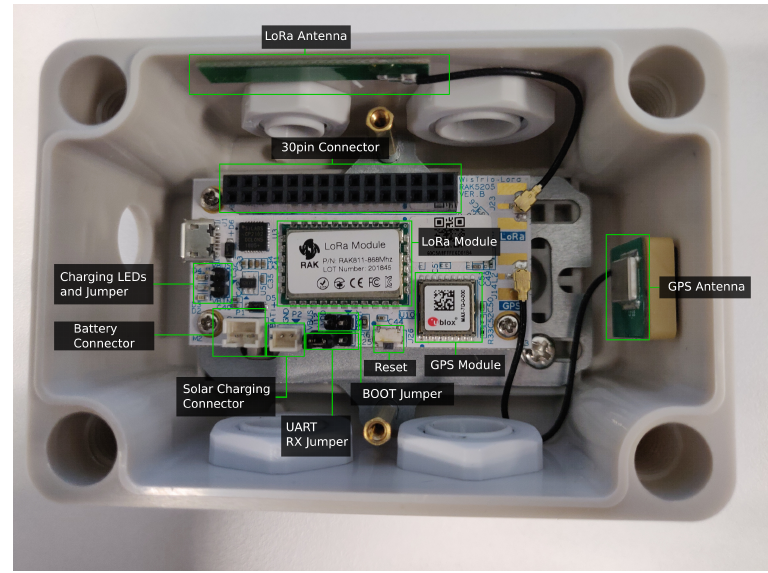
Figure 15. Components of the 868 MHz LoRaWAN node. Table 6. Main specifications of the 868 MHz LoRaWAN